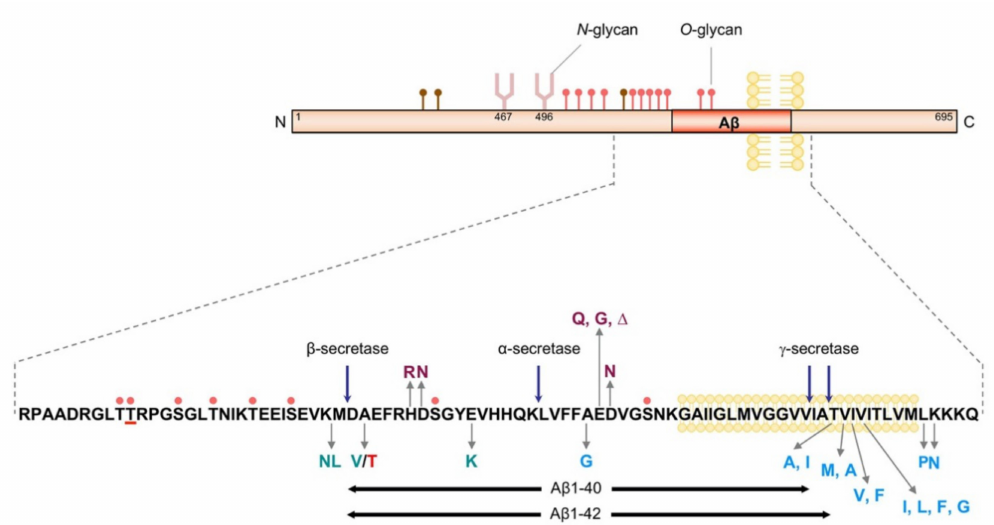
Figure 1. Schematic model of APP. Reported O -glycosylation sites and N -glycosylation sites are indicated. The O -glycan in brown means that these residues have been reported to have the potential to be modified by O -GlcNAc. Amino acid mutations labeled in green are mutations that a ff ect β -cleavage. Mutations in blue a ff ect γ -cleavage. Mutations in purple a ff ect cohesiveness. The mutation in red is the Icelandic mutation (A673T). The pink dots indicate Ser or Thr residues that can be modified with O -glycans. The underlined Thr residue is O -glycosylated by